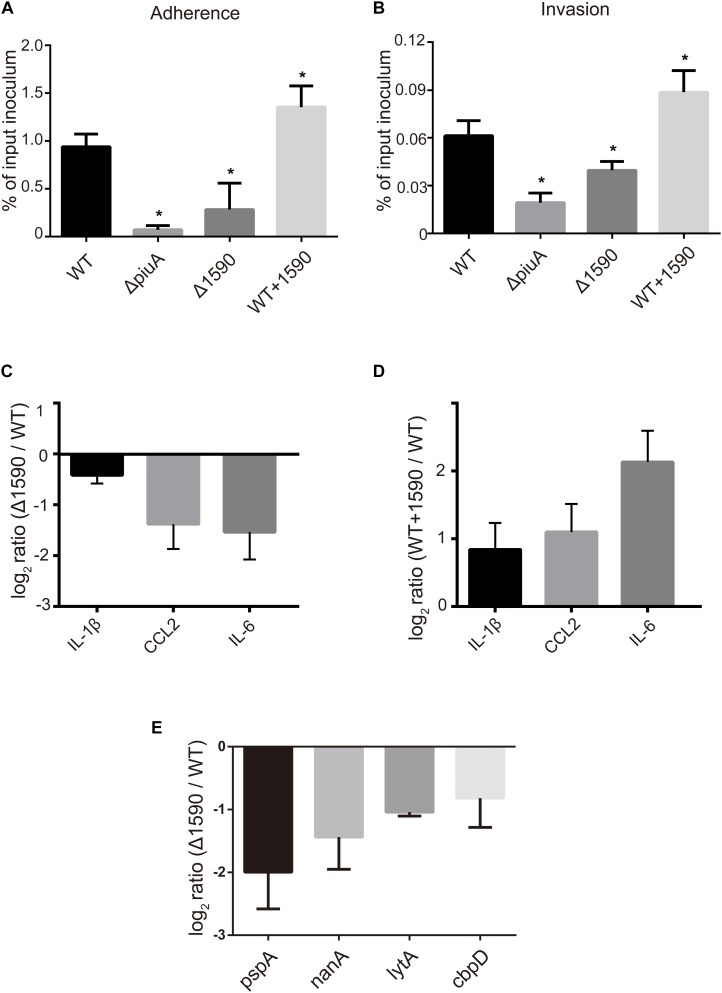
SPD_1590 promotes S. pneumoniae pathogenicity to A549 cells. (A) The adherence ability of WT, Δ1590, and WT+1590 strains. (B) The intracellular invasion ability of WT, Δ1590, and WT+1590 strains. ∗p < 0.05 compared to WT. (C,D) The mRNA expression levels of three inflammatory factors in A549 cells co-cultured with Δ1590 and WT+1590, respectively, analyzed by RT-qPCR. Actin was used as an internal control. (E) The mRNA expression of four virulence factors in Δ1590 compared to that in WT, analyzed by RT-qPCR. 16S rRNA was used as an internal control.